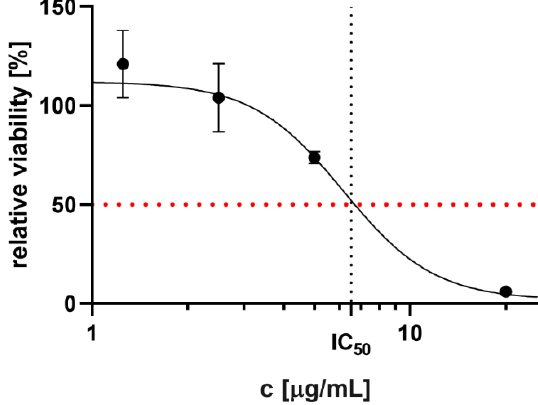
Figure 2. Relative cell viability determined after COME application. Results are expressed as percentage of viability of untreated cells (contained only 0.1 v / v DMSO), particular point are means ± standard error of the mean (SEM). Dashed lines indicate IC 50 value.